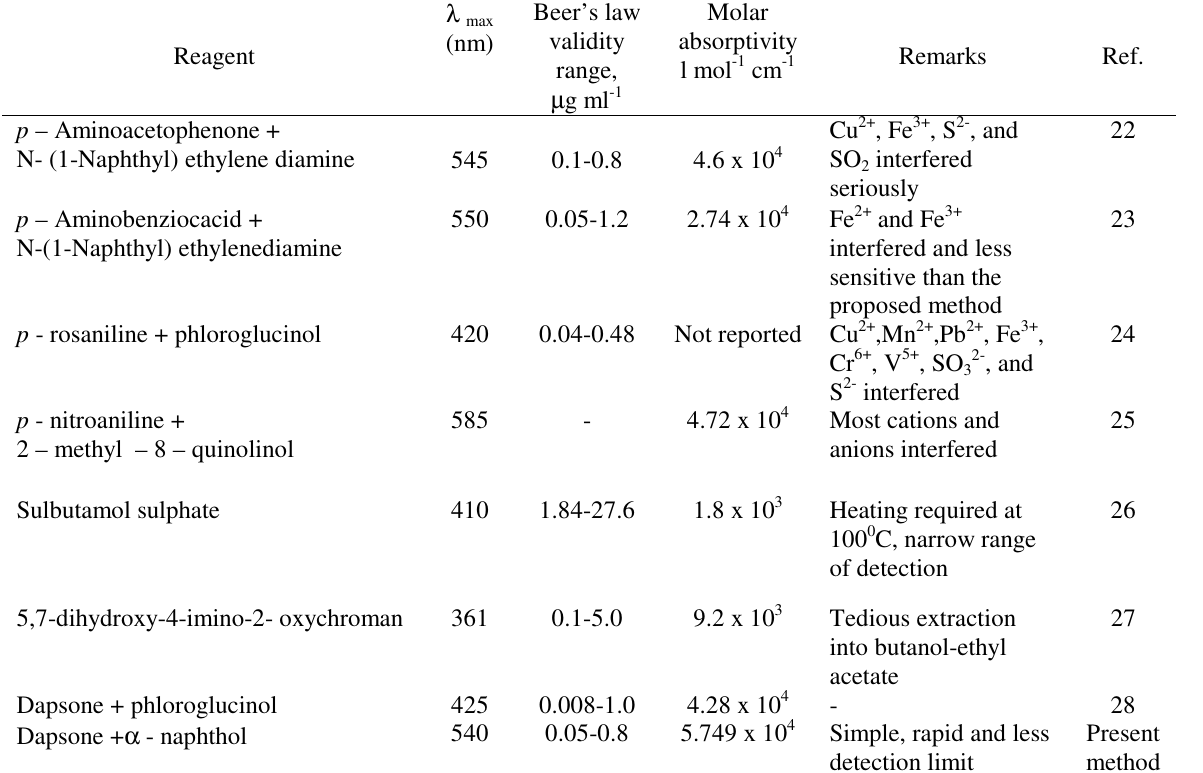
Table 3. Comparison of Spectrophotometric Determination of NO¯ 2 with Other